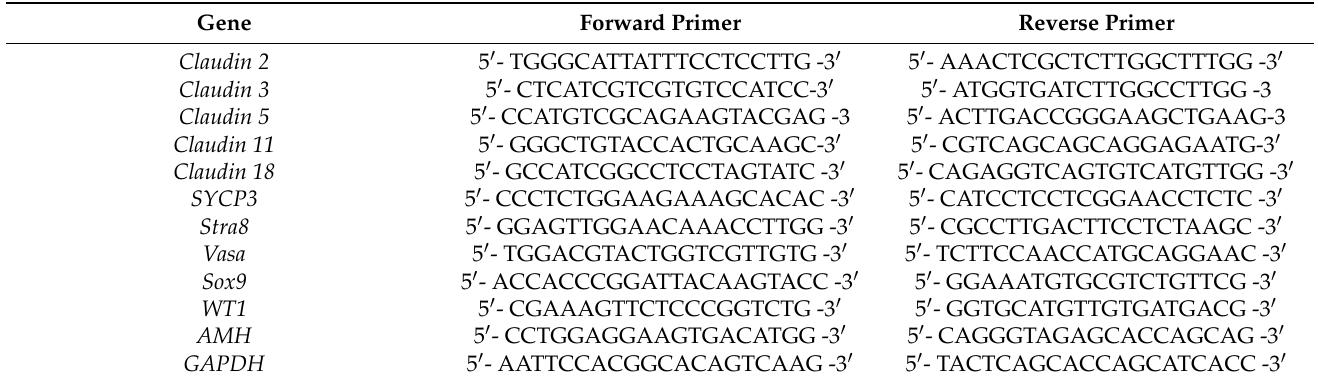
Table 2. Primers used for real-time reverse transcription–polymerase chain reaction of cDNA from canine